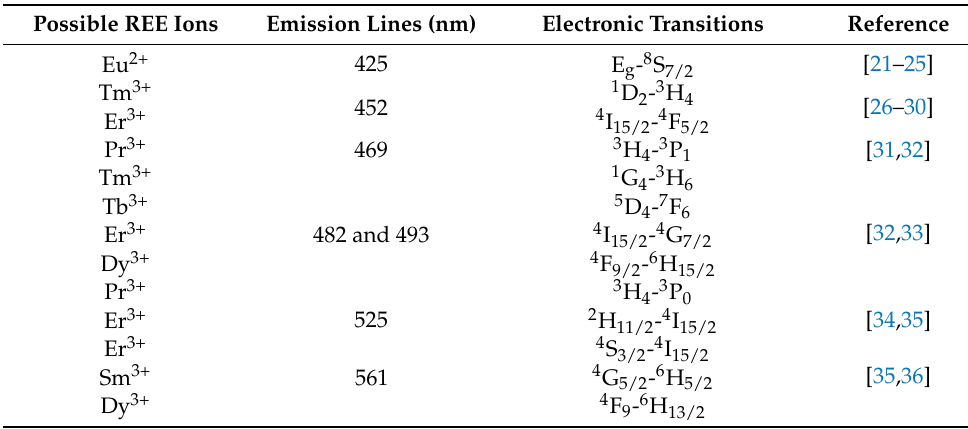
Table 2. Emission lines and electronic transitions of natural fluorite.